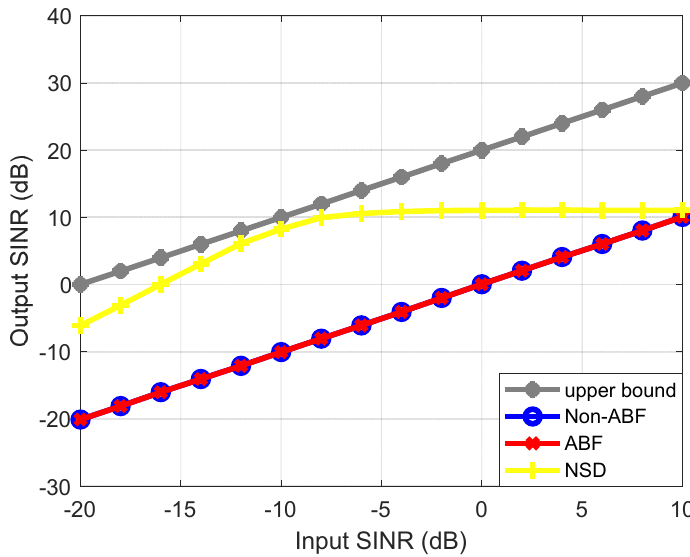
Figure 12. The output SINR performance of NFT under anti-jamming technology.